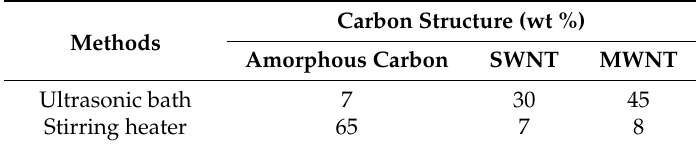
Table 2. Mass percentage of carbon structures in pristine CNTs using ultrasonic bath and stirring